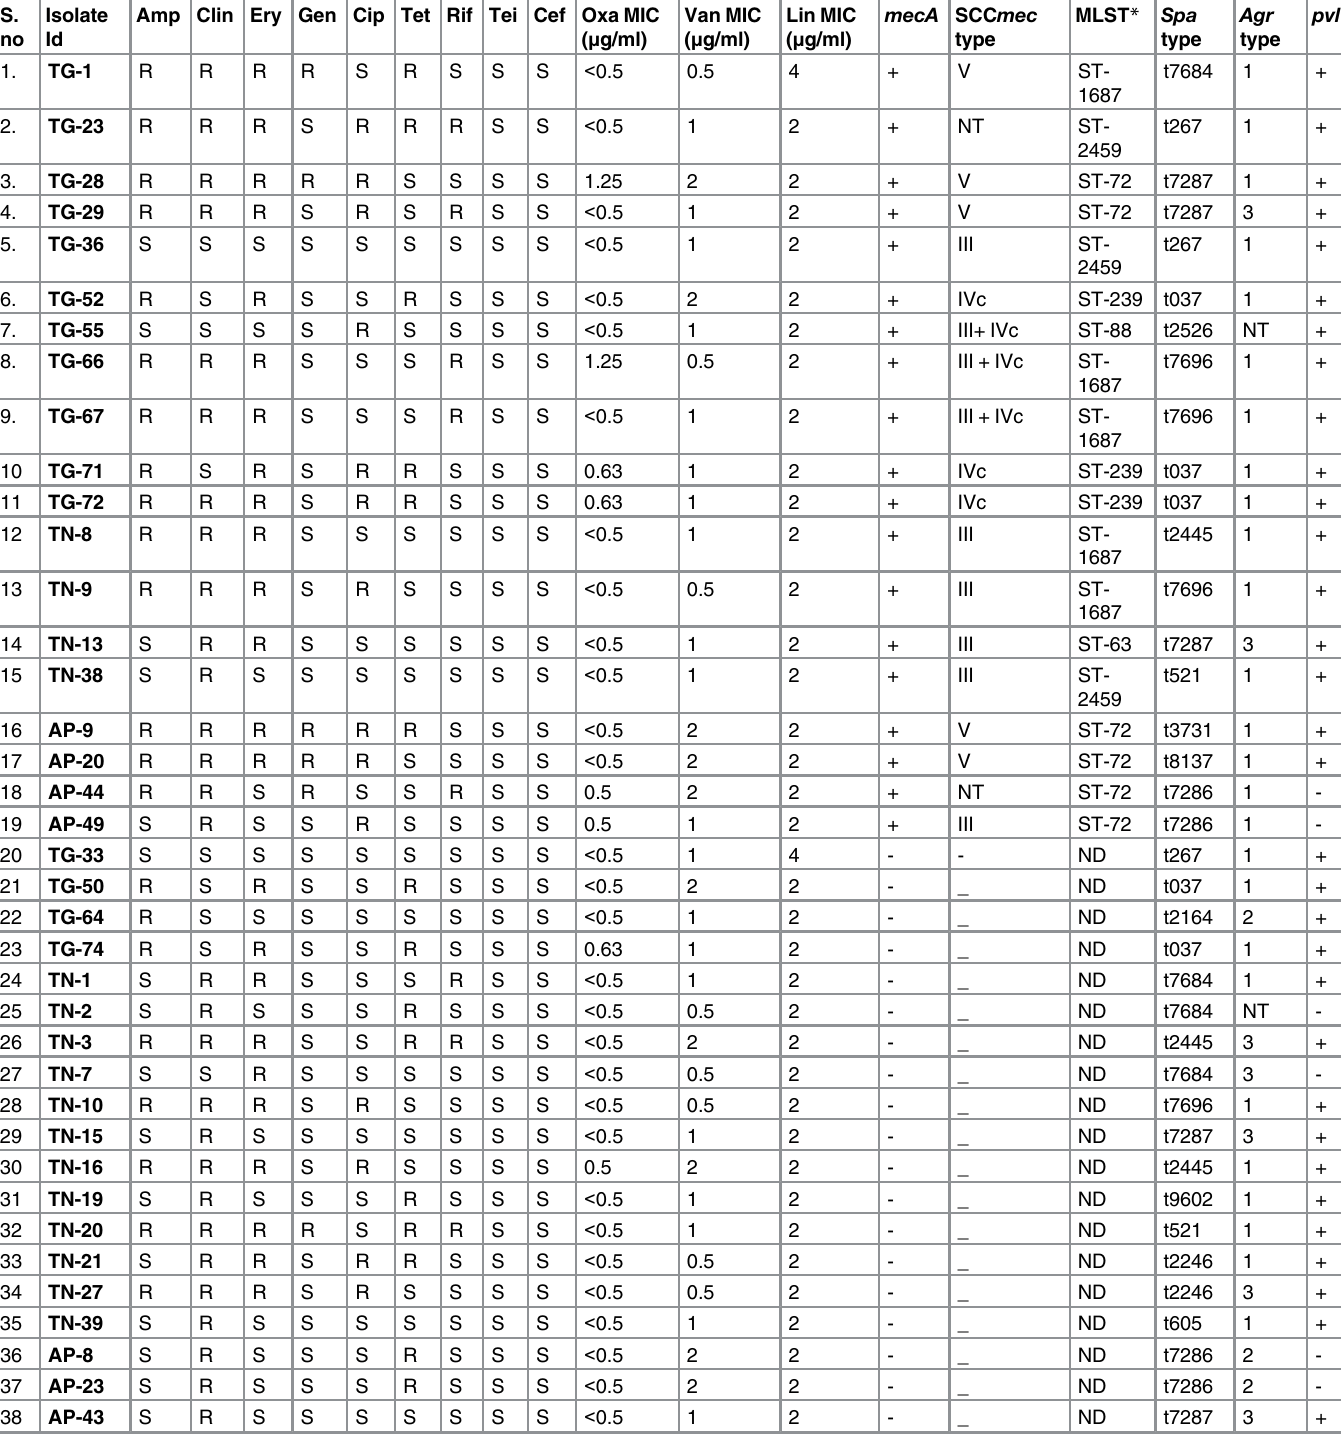
Table 1. Genotypic and phenotypic characterization of MRSA and MSSA clinical isolates causing bovine mastitis in India. S. Isolate no